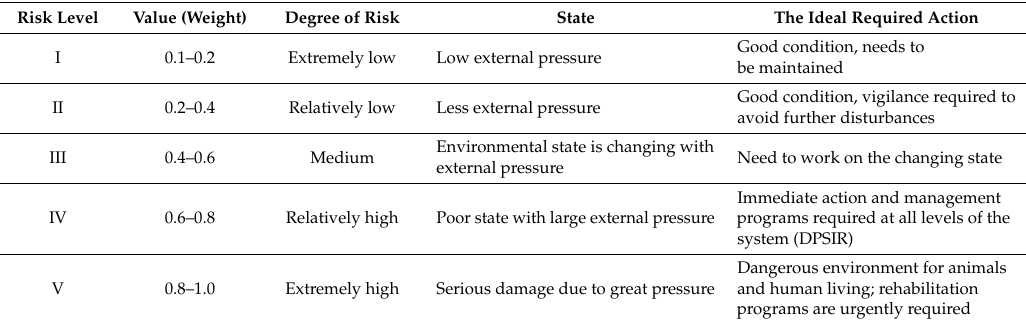
Table 5. Classification of risk level and interpretation